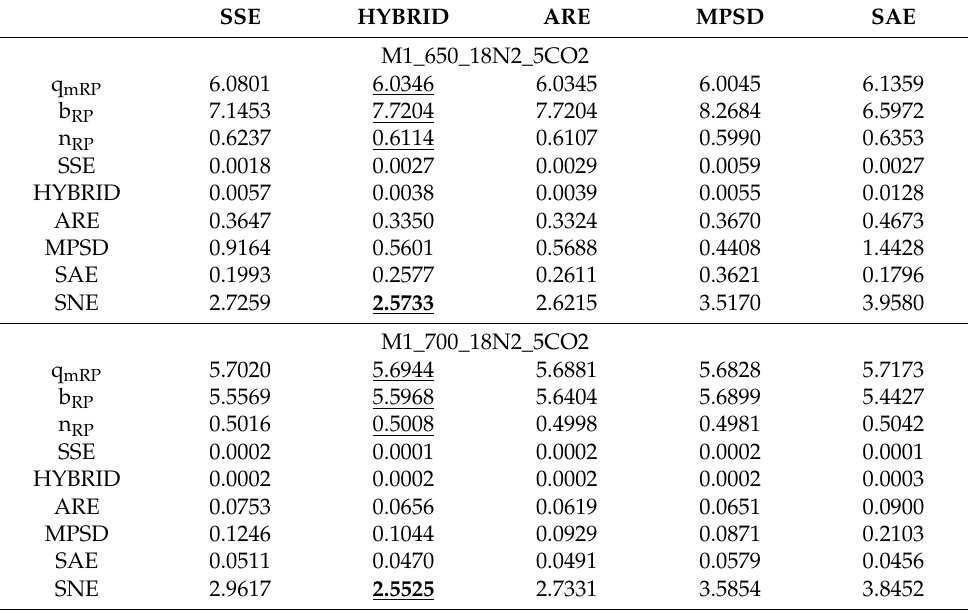
Table 12. Radke-Prausnitz isotherms constants with error analysis